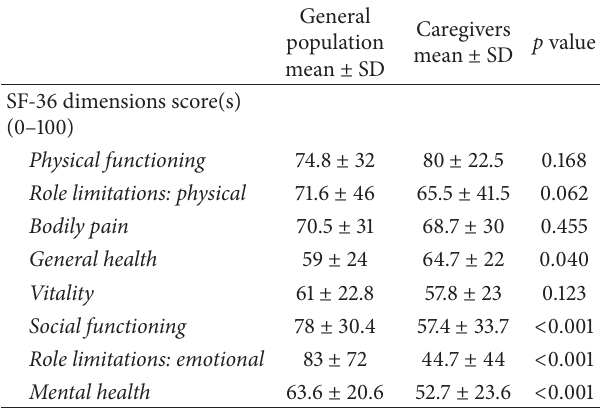
Table 5: Comparisons of SF-36 dimensions between study’s sample and an age-sex matched sample from the general population (retrieved from Pappa et al.